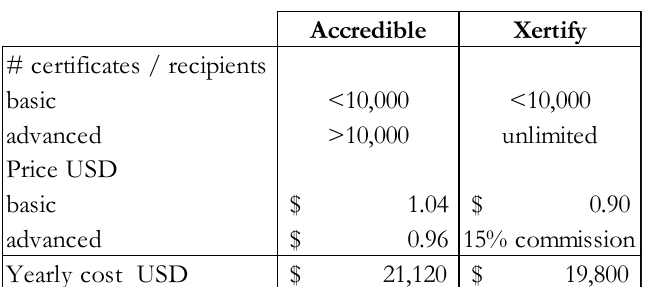
Table 1: Cost per year for issuing organizations of using certification providers.